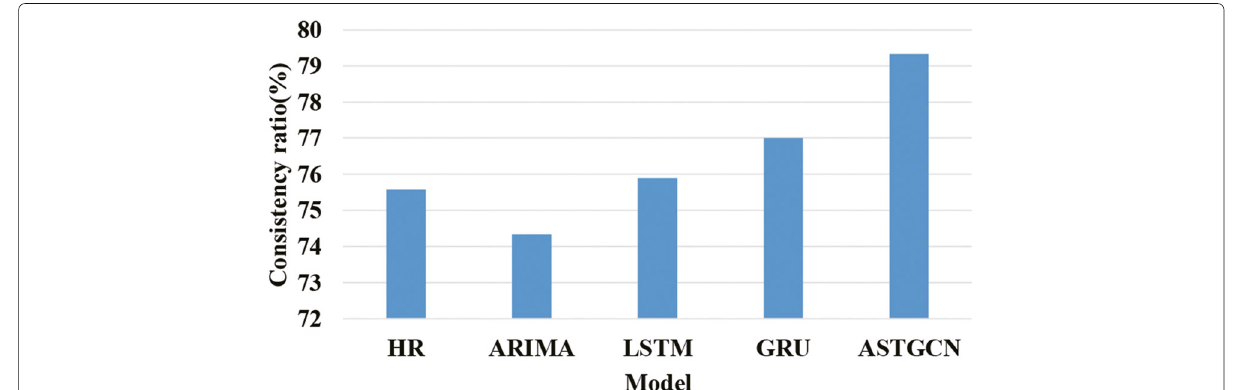
Fig. 5 Consistency rate of data between the cloud and IoT nodes for different data prediction models